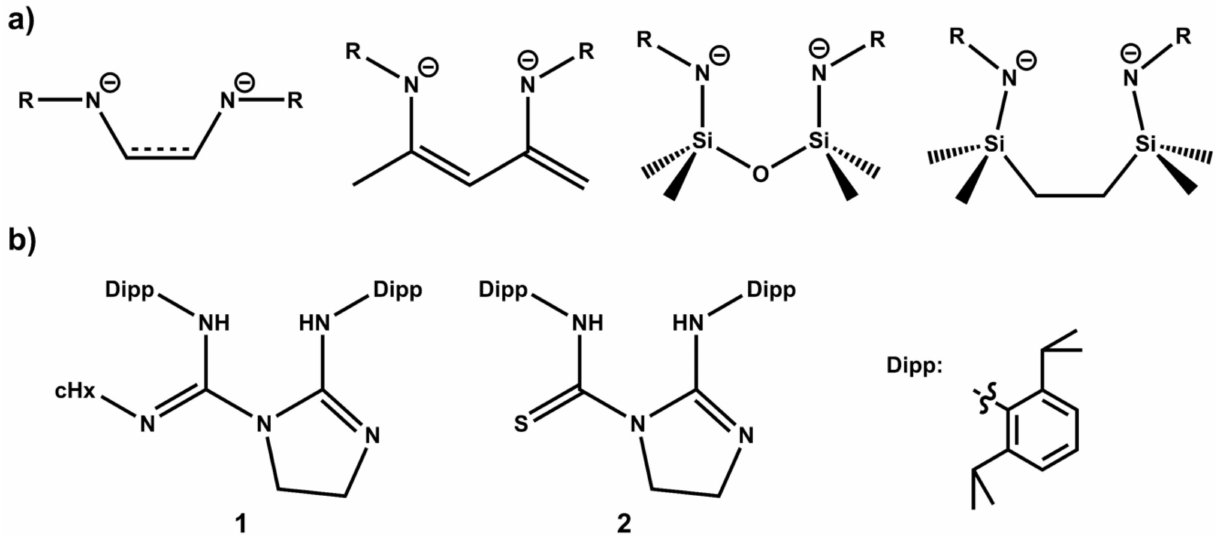
Figure 1. ( a ) Selected examples of dianionic N,N-chelating ligands. ( b ) The diprotic biguanide 1 and carbothiamide 2 used in this